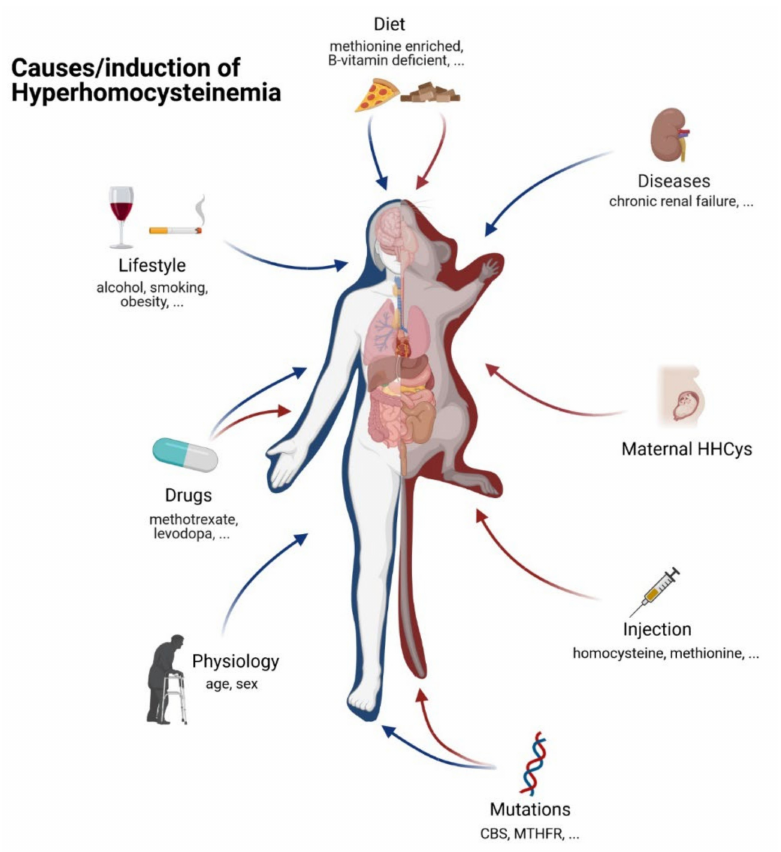
Figure 5. The most common causes of HHCys in humans (blue) and induction methods in animal models (red); created with